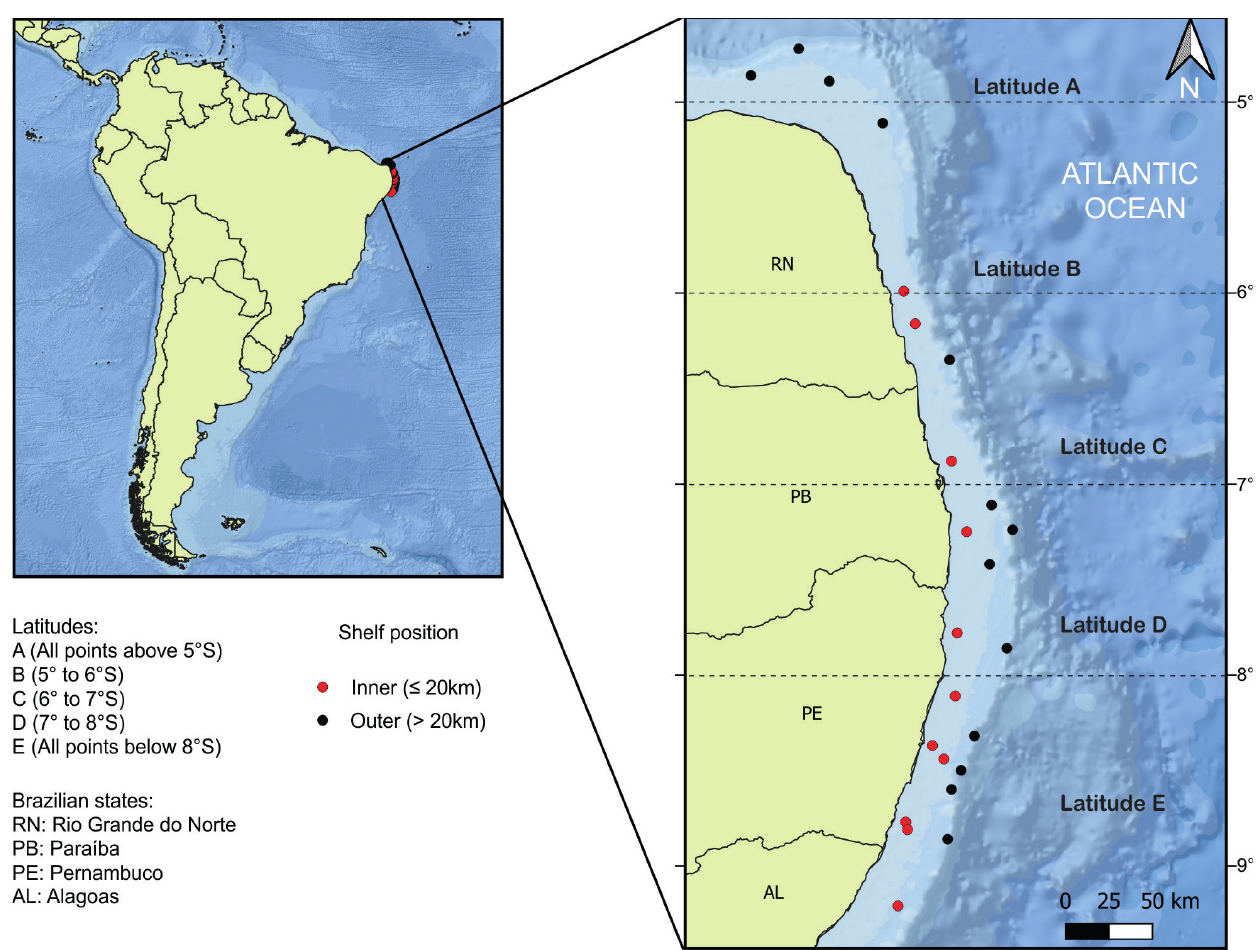
FIGURE 1 | Study area and sample points along the continental shelf of the northeast coast of Brazil. Red dots indicate samples for inner position (≤ 20 km) and black dots for outer (> 20